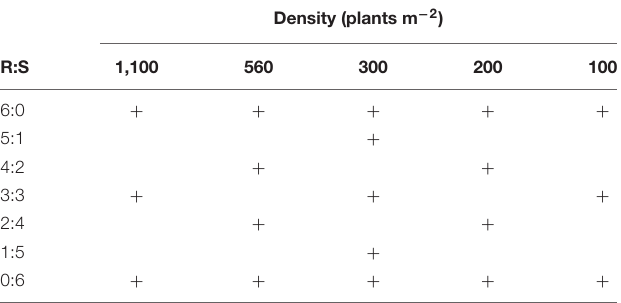
Figure 3 allowed the investigation of the impact of A.